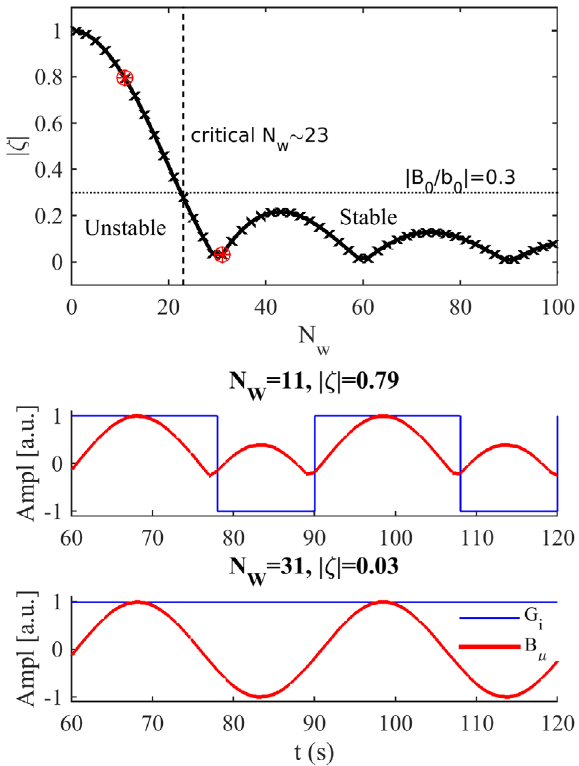
assuming B = 0.3 nT, W 0 and the resulting B . i µ